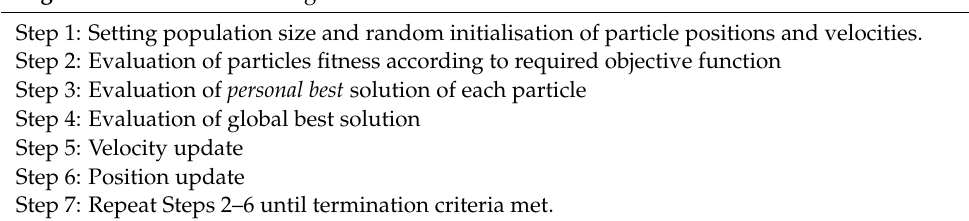
Algorithm 1 Classical PSO